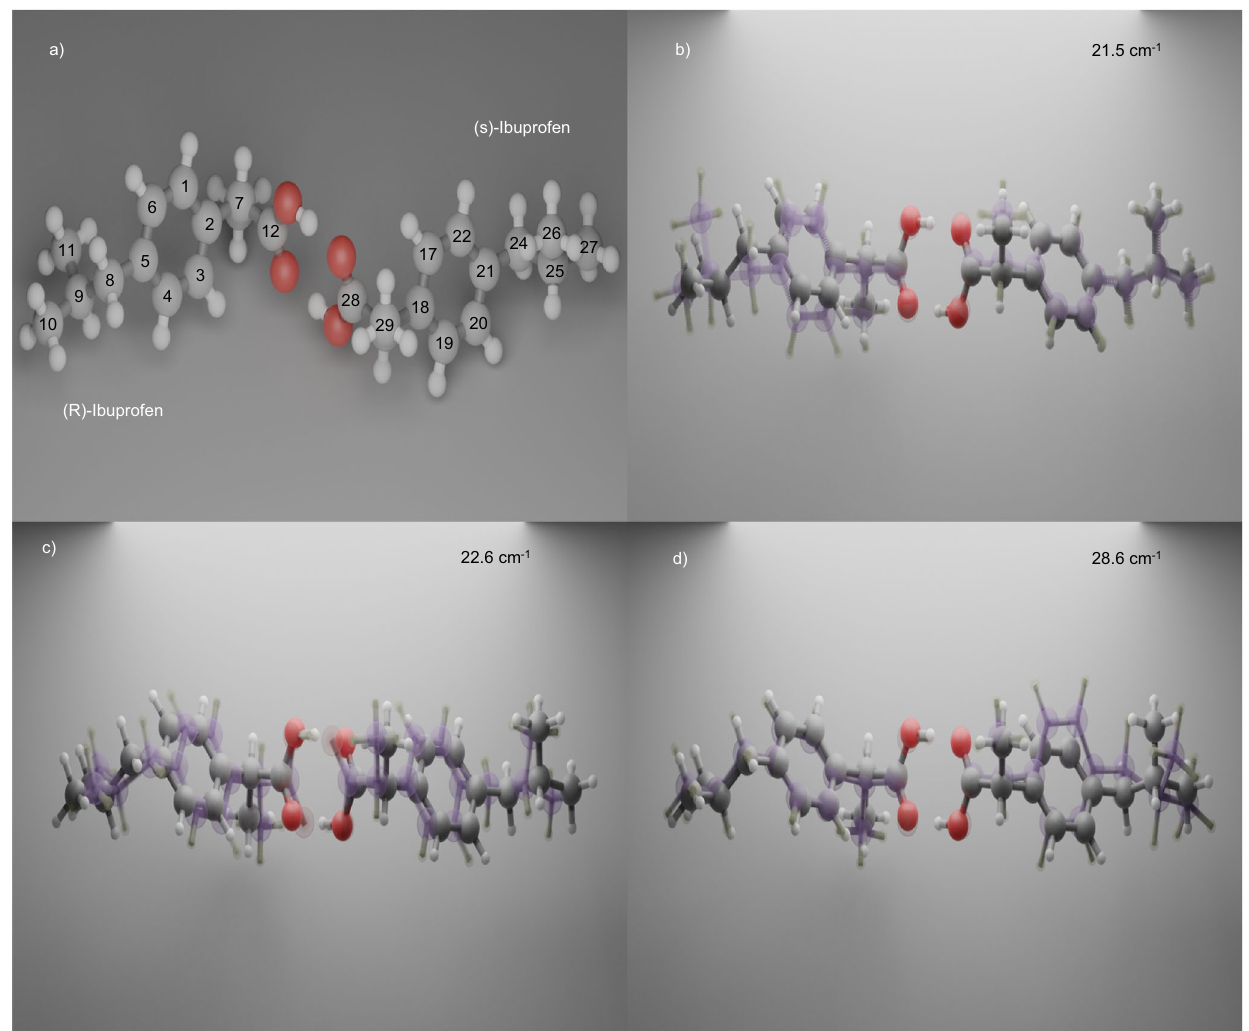
Fig. 1 | Atom labelling and vibrational modes. a The Ibuprofen dimer with the numberingofthecarbonatoms. b – d Thethreeintermolecularmodesofthedimer (see Supplementary Movie 1 – 3). The structures appearing in contrasted and semi-